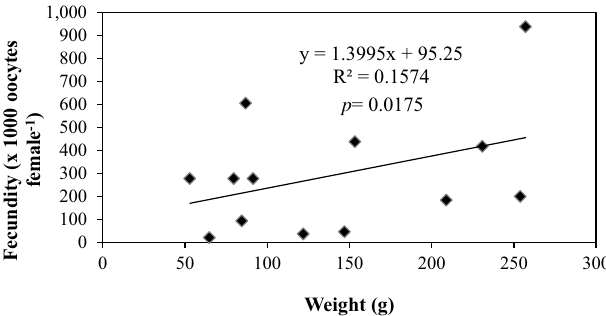
Fig. 4. Cittarium pica. Relationship between female wet live weight, shell length and its fecundity.